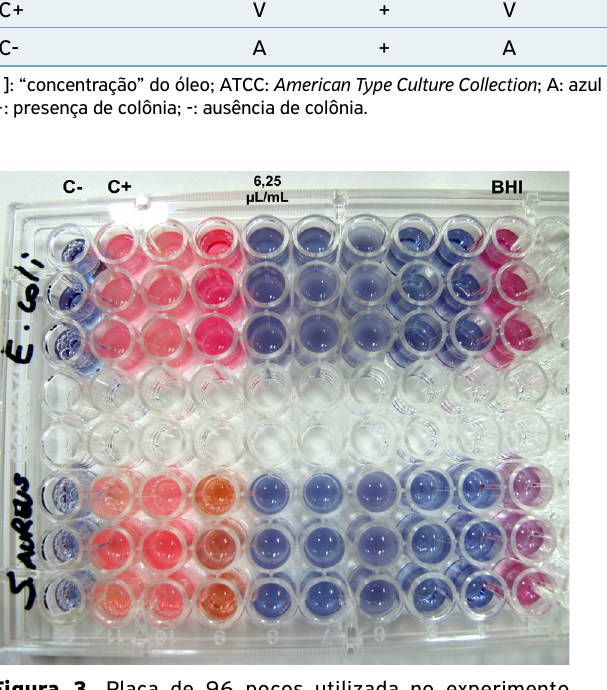
Figura 3. Placa de 96 poços utilizada no experimento de microdiluição após adição de resazurina para a determinação da concentração inibitória mínima do O. vulgare sobre as cepas E. coli (ATCC 25922) e S. aureus (ATCC